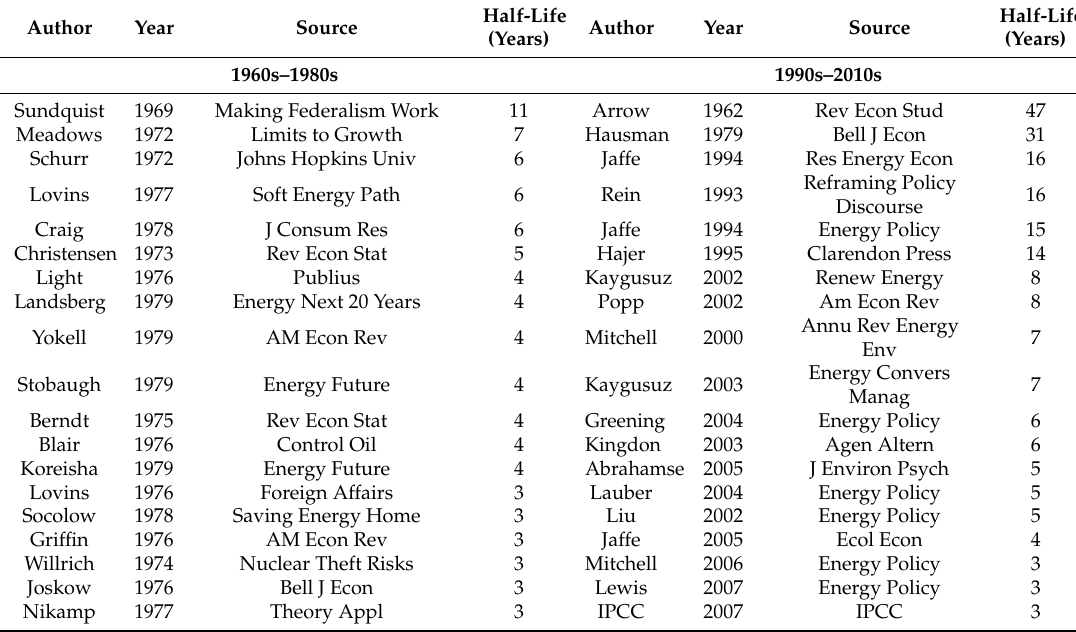
Table 3. Selected notable/representative citations from